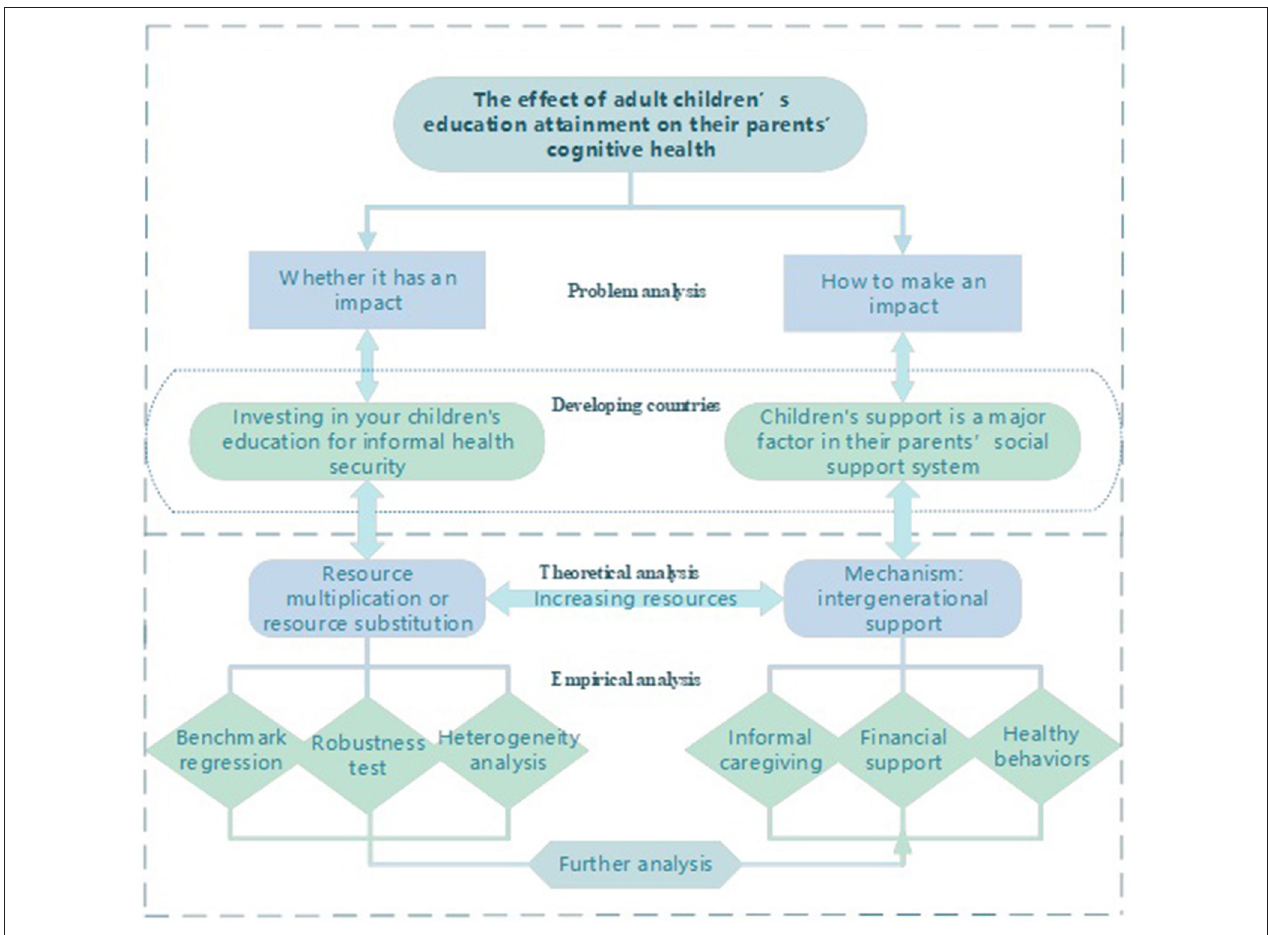
FIGURE 1 | The analysis